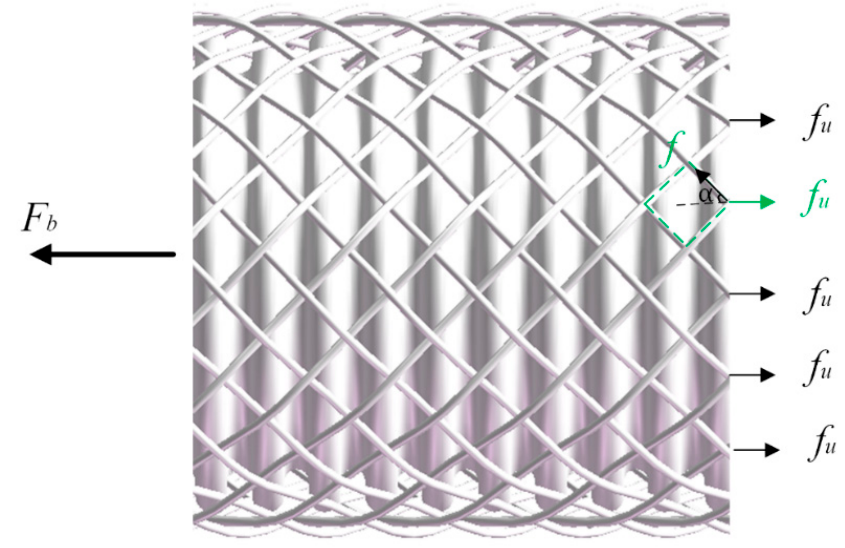
Figure 4. Tubular braid under axial load.